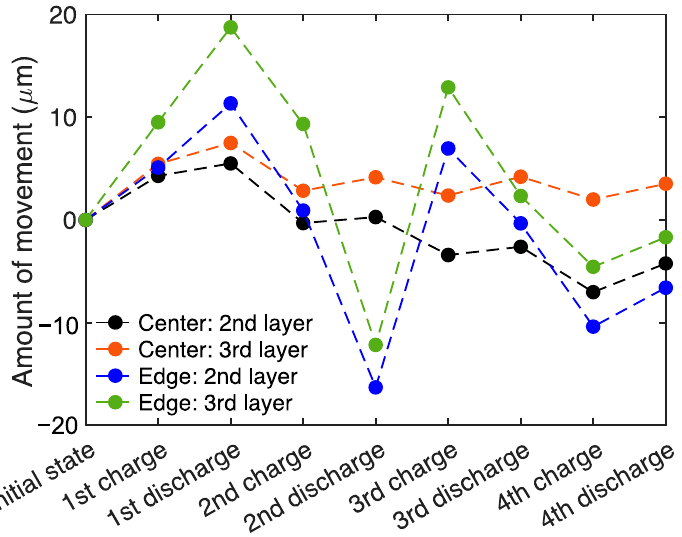
Figure 7. Amount of movement of cathode Al collector position corresponding to each cycle. The positive value of the y -axis corresponds to the z − direction shown in the coordinate in Figure 1a.